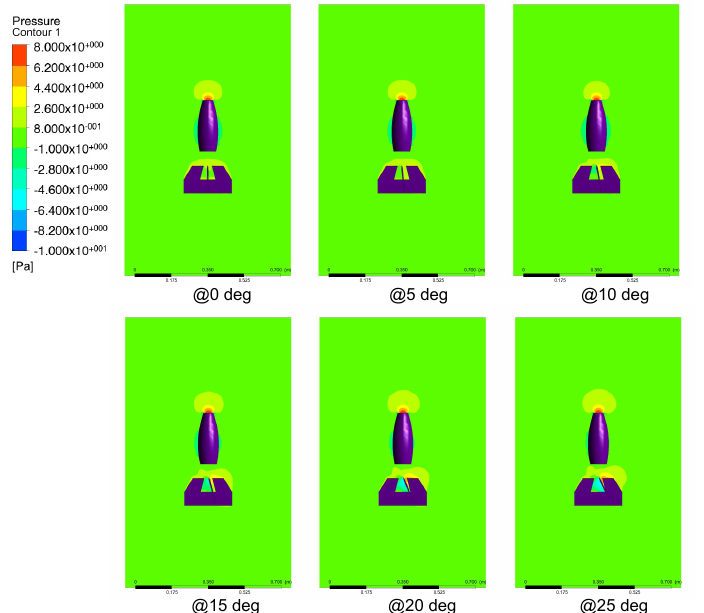
Figure 10. Pressure contours generated for MCR UAV v3.0 with a control-surface angle of deflection from 5 to 25 degrees for Aileron 1.